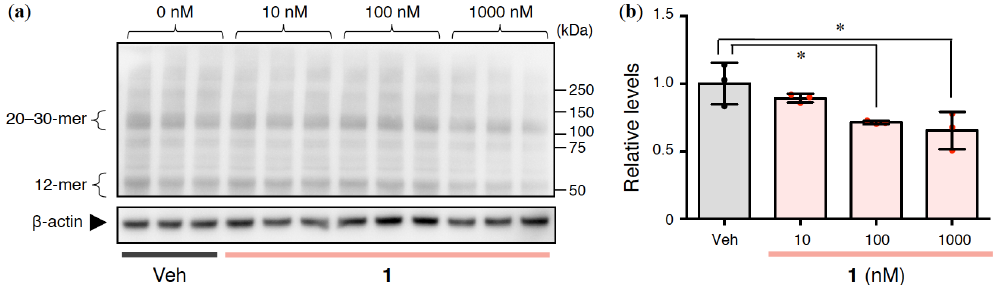
Figure 4. ( a , b ) Toxic oligomer formation in lysate from rat primary cerebral cortex cells treated with 1 at the indicated concentration for 6 h. ( a ) The representative Western blot shown was probed with anti-A β 42 toxic turn (24B3) antibody. ( b ) Band intensities corresponding to 20–30-mers relative to β -actin in ( a ) are presented as mean ± SD ( n = 3). * p < 0.05 versus Veh (vehicle). Red or black dots represent each value.